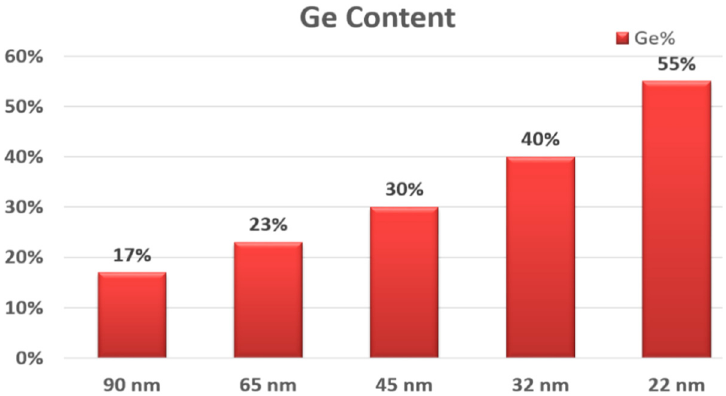
Figure 17. Ge contents in source and drain (S/D) regions in different technology nodes [92].